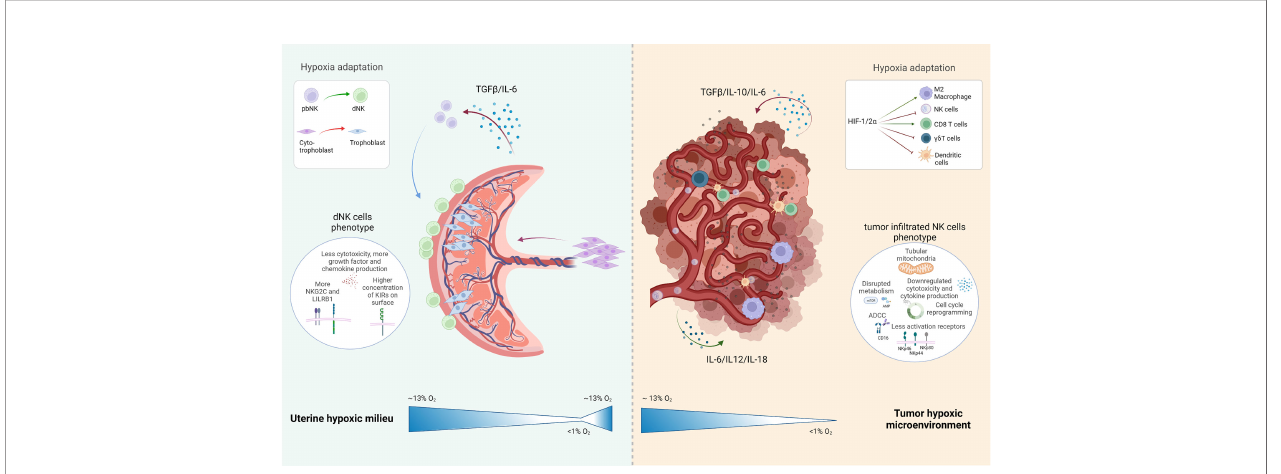
FIGURE 2 | Schematic representation of the uterine hypoxic milieu and the tumor environment with special attention drawn to the present NK cell subtype and their development under hypoxic conditions: The uterine milieu shows a maturation of peripheral blood (pb)NK cells to decidual (d)NK cells, which are expressing a more angiogenic phenotype with various inhibitory NK cells receptors expressed in their surface; the tumor microenvironment depicts several inhibitory or activating effects with induced hypoxia on resident immune cells, which leads to an overall negative in fl uence on the immune reaction at the tumor side. Created with